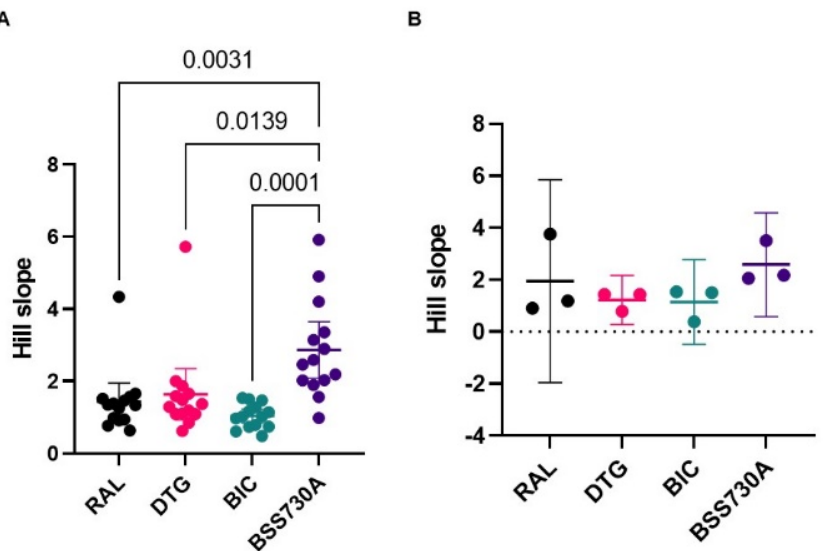
Figure 2. Hill slope values of RAL, DTG, BIC, and BSS-730A for HIV-2 isolates. ( A ) Isolates from RAL-naïve patients; ( B ) isolates from RAL-experienced patients. Lines indicate mean values with 95% CI. One-way ANOVA with Tukey’s multiple comparisons test was used. Only p -values < 0.05 are shown.